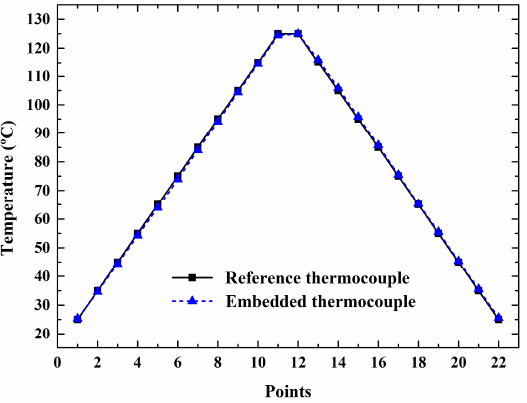
Figure 4. Calibration test of the K-type embedded thermocouple.